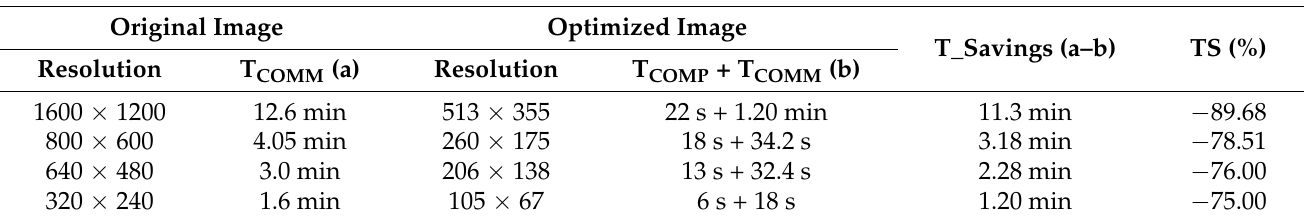
Table 11. Overall time savings in transmitting an optimized image (considering both its computing and transmitting time) as compared to transmitting an original image (transmitting time only since no computation needed)).